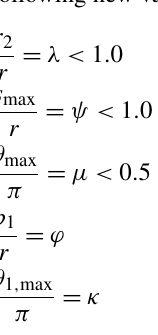
Figure 1. Terminology of two-circular arc cam (Grohe and Russ,